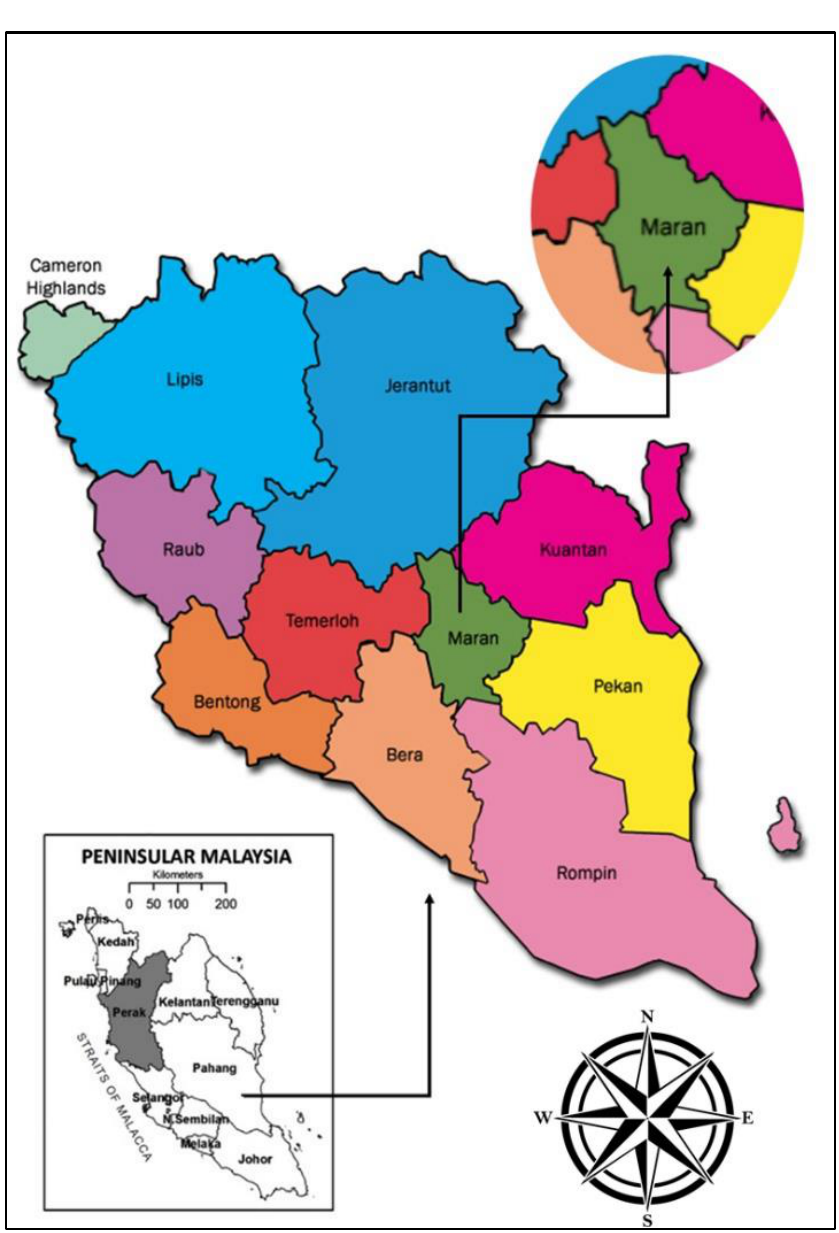
Figure 1. Location of FRIM Research Station at Maran Pahang, Malaysia .